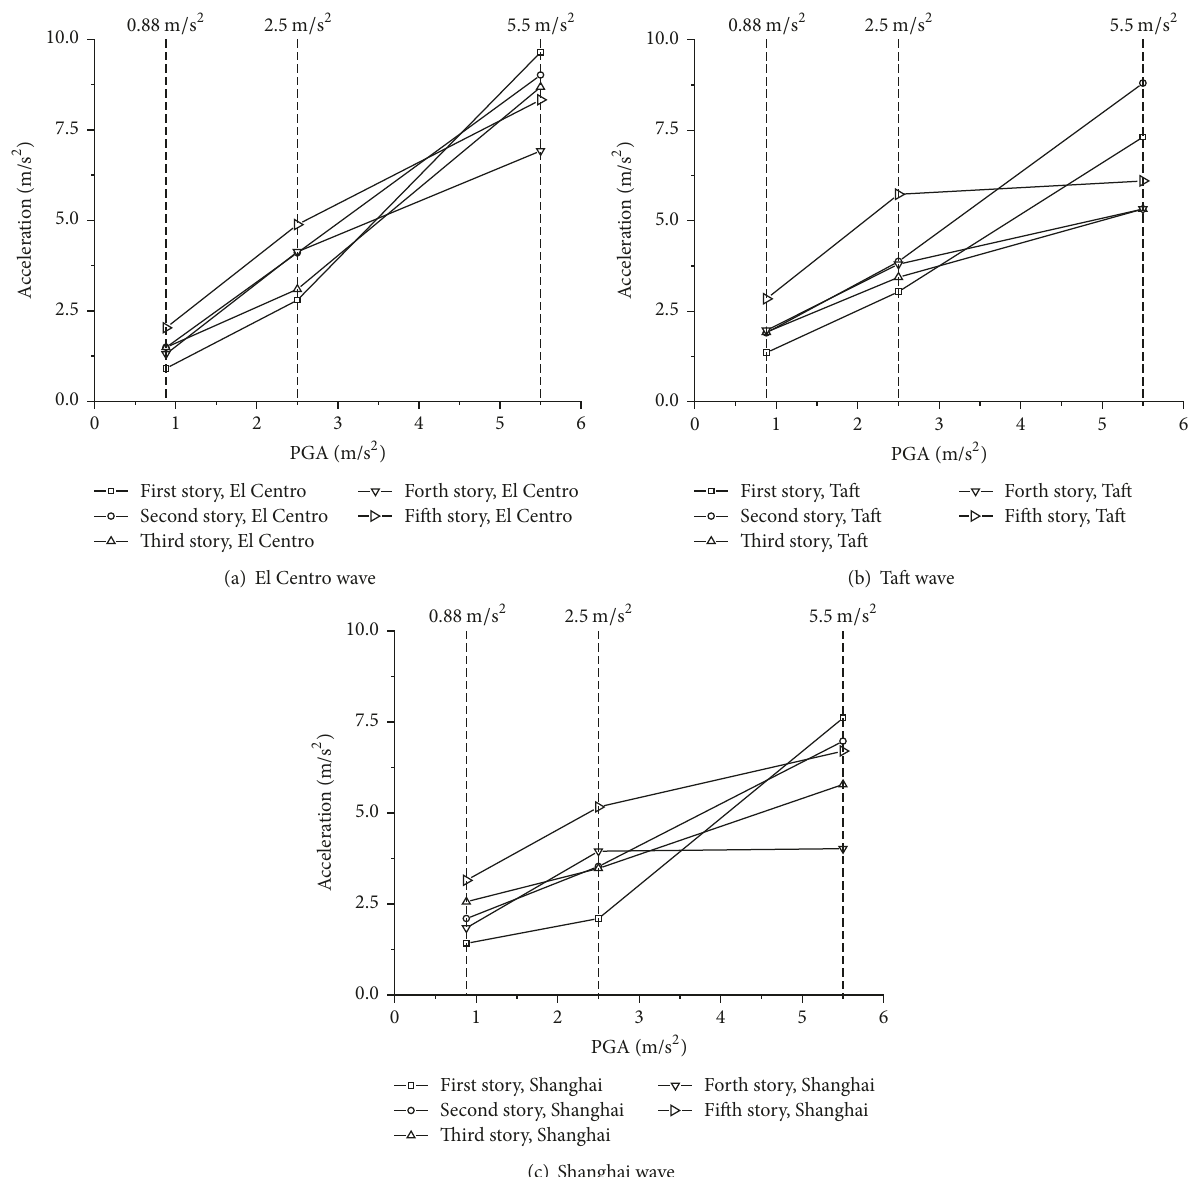
Figure 10: Story acceleration versus target PGA of USMS